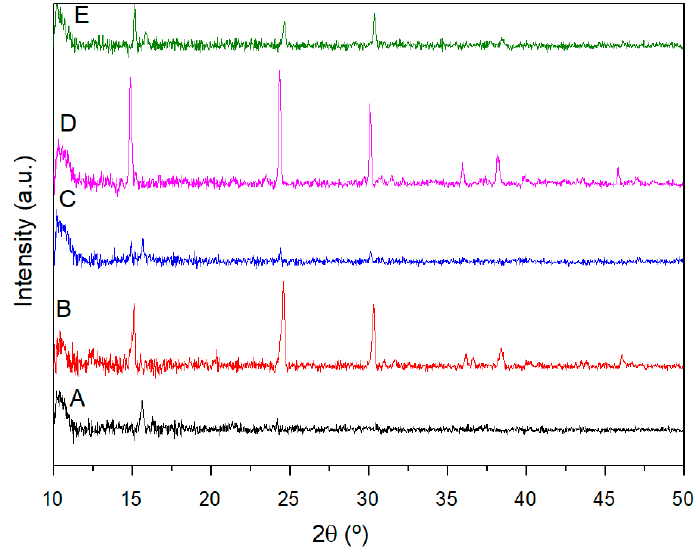
Figure 3. X-ray diffraction (XRD) patterns of films. (A) Control, (B) Copena F1 without fibre (Copwtf), Figure 3. X-ray di ff raction (XRD) patterns of films. ( A ) Control, ( B ) Copena F1 without fibre (Copwtf), (C) Copena F1 with fibre (Copwf), (D) Villanueva without fibre (Viwtf) and (E) Villanueva with fibre ( C ) Copena F1 with fibre (Copwf), ( D ) Villanueva without fibre (Viwtf) and ( E ) Villanueva with (Viwf). fibre